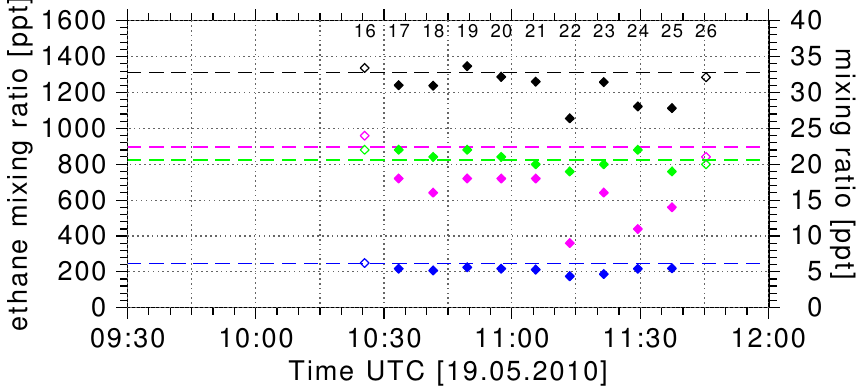
Fig. 9. Selected non-methane hydrocarbons (NMHCs) and perchloroethylene (PCE) measurements in whole air samples collected on 19 May 2010. Same representation as in Fig. 6.